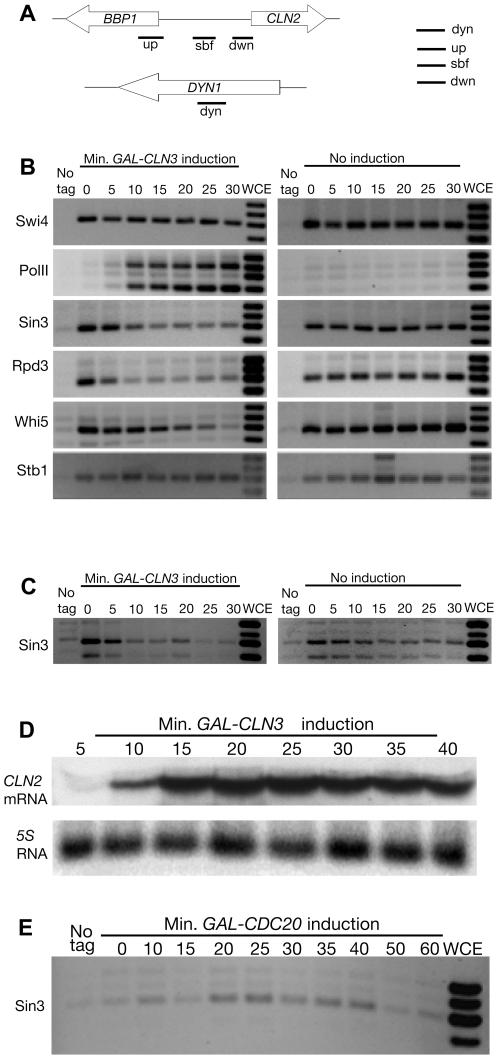
Proteins at the CLN2 promoter.(A) Map of the CLN2 promoter, showing the location of the up, sbf, and dwn probes in the BBP1-CLN2 intergenic region. The sbf probe overlaps the consensus SBF binding sites. The dyn probe is in the middle of the DYN1 open reading frame, several kilobases from the nearest promoter. On the right is shown the relative order of these probes on gels; i.e., the dyn probe has the lowest mobility, and the dwn probe the highest mobility. (B) Proteins at the CLN2 promoter as a function of CLN3 induction. GAL-CLN3 expression was induced (left) or not (right) by the addition of galactose. Samples were taken from 0 to 30 min. Proteins were cross-linked to DNA and processed as described, and TAP-tagged proteins (from strains HWL61, HWL59, HWL51, HWL62, HWL77, and HWL128) were immunoprecipitated. Coprecipitated DNA fragments were identified by PCR using probes amplifying fragments described above in (A). Whole cell extract (WCE) was also amplified, as a positive control. Samples (HWL49) from cells lacking any TAP-tagged protein were processed as a negative control (No tag). The parental strain was HWL49, with partial genotype GAL-CLN3 bck2 cdc34-2. (C) As (B), but TAP-tagged Sin3 is being assayed by ChIP at the YOX1 promoter, instead of at the CLN2 promoter. (D) Kinetics of induction of the CLN2 mRNA, by Northern analysis. 5S RNA serves as a loading control. (E) GAL-CDC20 cdc20 SIN3-TAP cells were arrested in M-phase in glucose, then GAL-CDC20 was induced at 0 time with galactose medium. The amount of Sin3-TAP associated with the CLN2 promoter was assayed during a timecourse. Budding initiates at about 50 min.